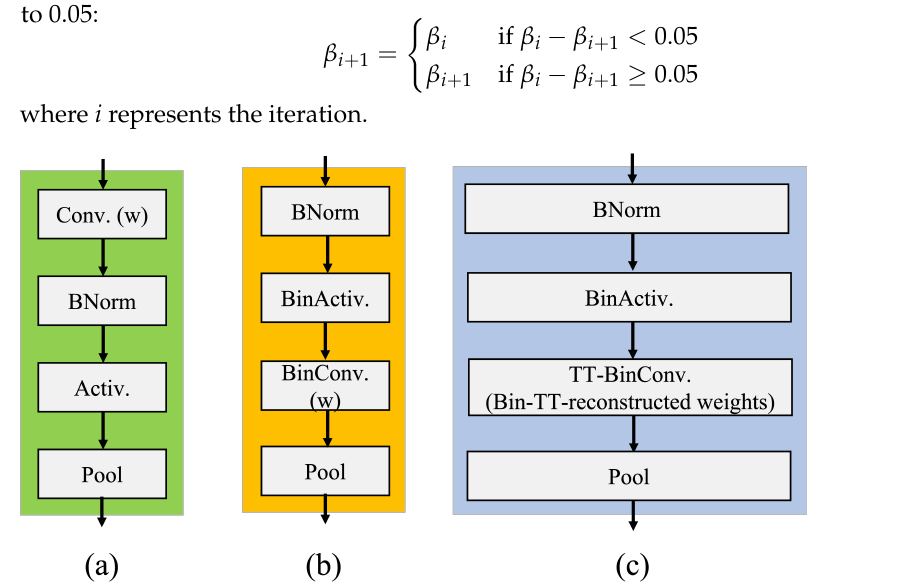
Figure 2. ( a ) Conventional CNN blocks, ( b ) XNOR-network blocks, ( c ) ABFLMC